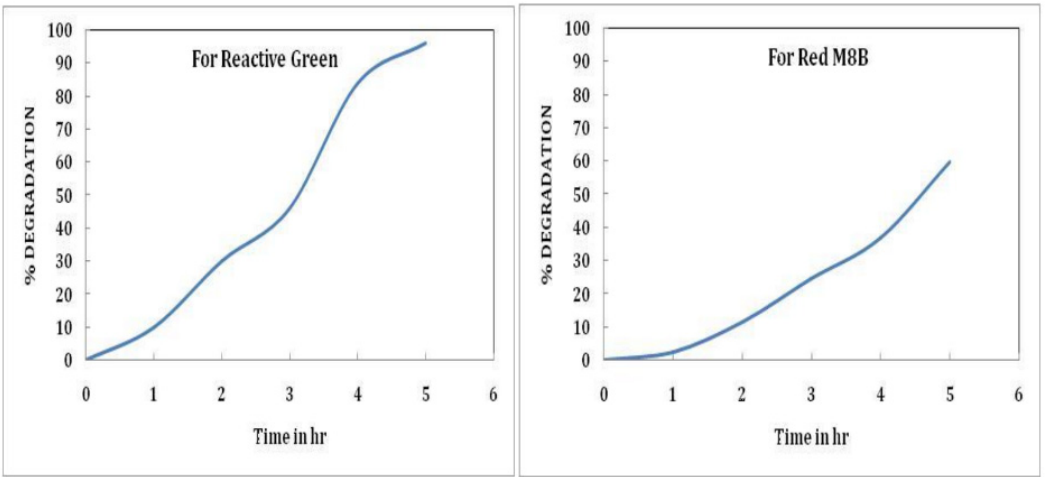
Fig. 17. Percent degradation of Red M8B and Reactive Green Dye at different Time